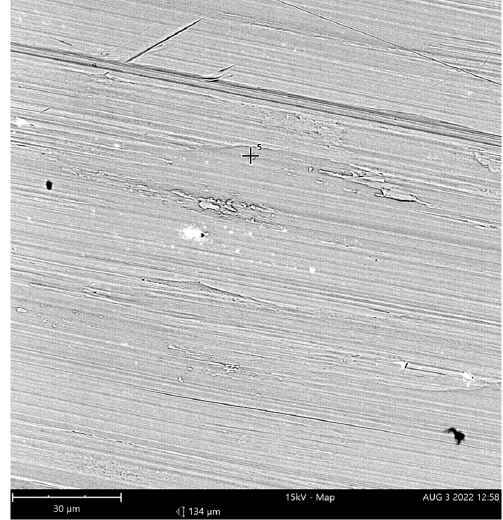
Figure 1. A SEM image of the material studied.